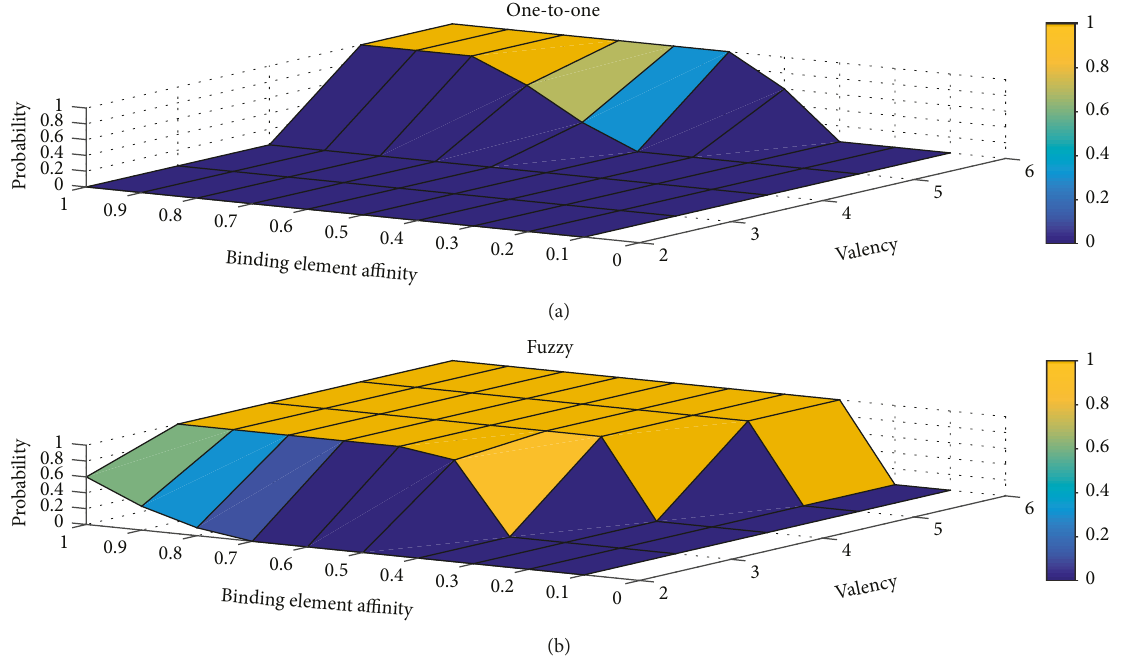
Figure 4: Probability of large polymers as a function of valency and binding element a ffi nity in one-to-one (a) and fuzzy (b) binding models. Valency is de fi ned as the number of binding elements, which a ffi nity ( s α (1)). Linker dynamics =0.35; box